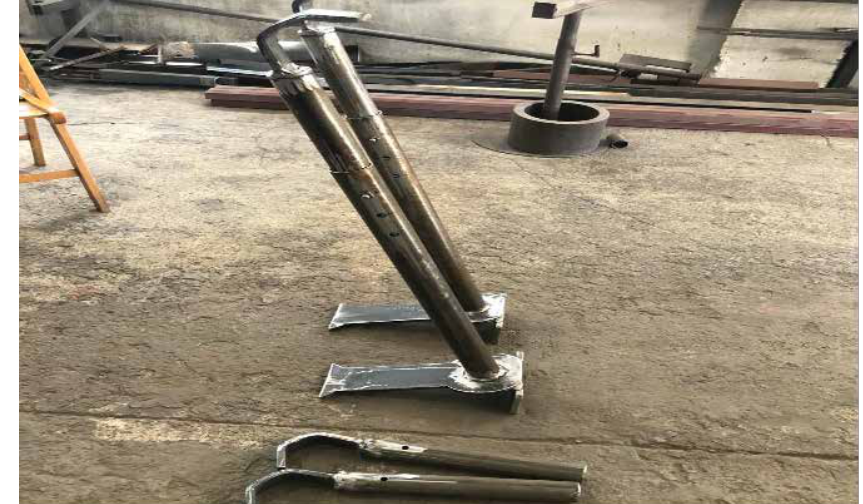
Figure 1. Adjustable eccentric hook